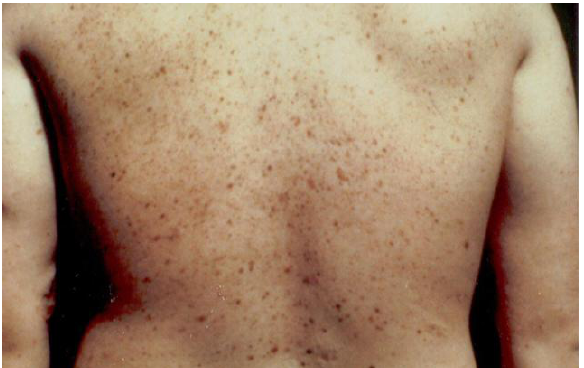
Figure 2. Photograph of the proband with multiple atypical nevi characterized by variegated coloration, irregular contours, and larger size than typical moles.